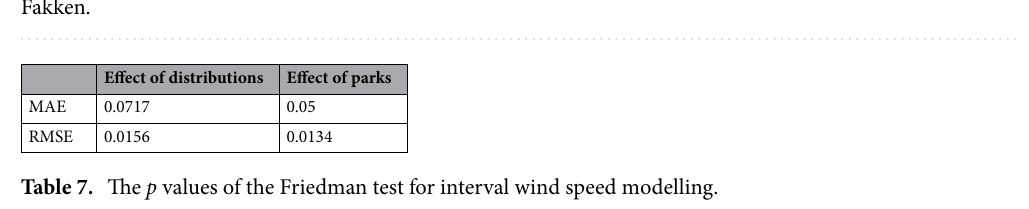
Figure 5. The RMSE of interval wind speed PDFs for NWP data from five sites and measurements from Fakken.